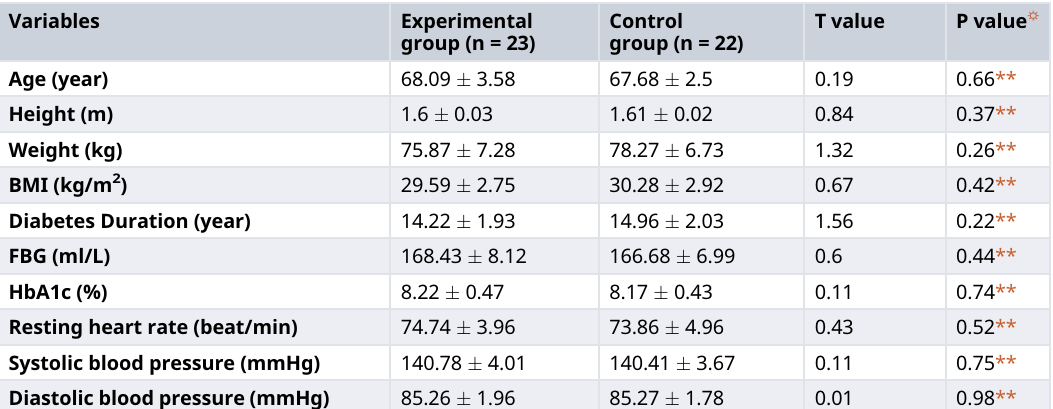
Table 1. The demographic characteristics of participants in both groups (Mean (cid:1) SD).